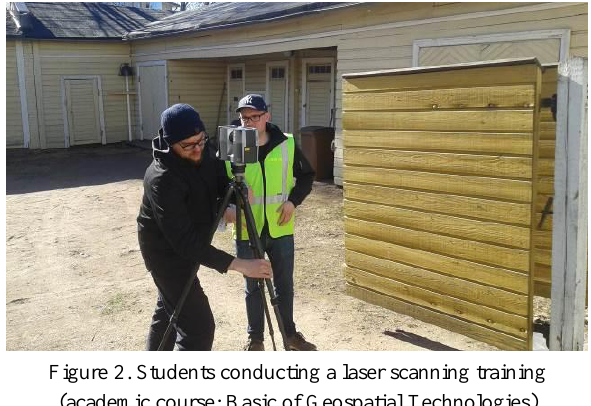
Figure 2. Students conducting a laser scanning